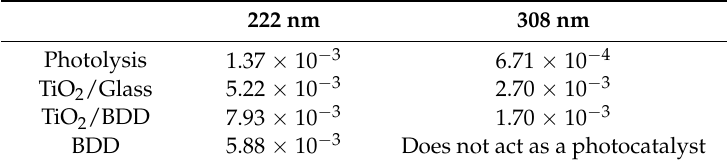
Figure 7. The kinetics of the photocatalytic reaction of MB under ( a ) 222 nm and ( b ) 308 nm UV light. The natural logarithm of C/C 0 is plotted versus photoirradiation time, where C and C 0 are the remaining and initial concentrations of MB, respectively. Linear regression lines for calculation of the reaction rate are also included. Note that BDD does not act as a photocatalyst under 308 nm UV light. Table 1. Estimated reaction rates (min − 1 ) in various